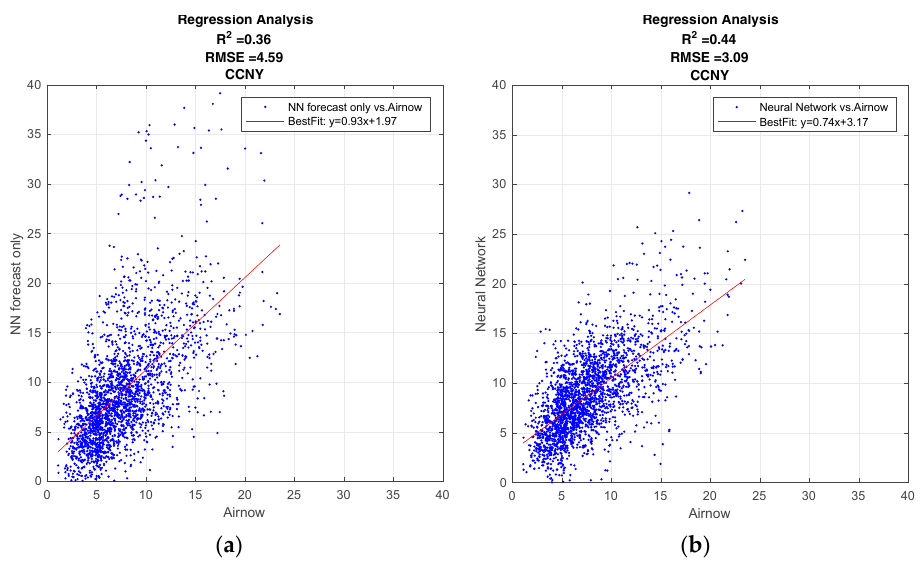
Figure 4. Results from the regression analysis to maximize Neural Network performance for the different scenarios. ( a ) NN designed with the forecast meteorological data (Scenario 1); ( b ) NN designed by taking the difference between the forecast and the current days measurements (Scenario 2).